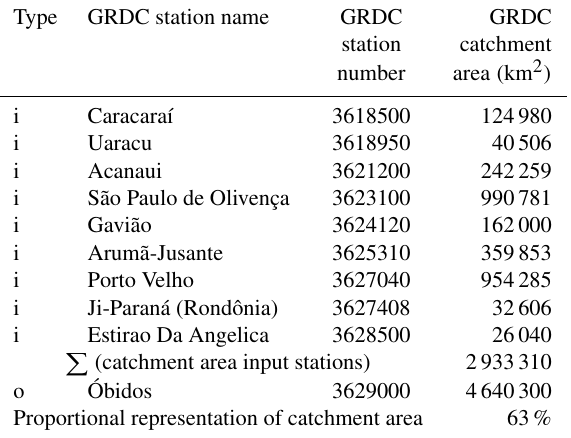
Table 2. List with catchment area per GRDC station located up- stream of Óbidos (type “i”) compared to catchment area of observa- tion station Óbidos (type “o”). All data are sourced from the official GRDC website